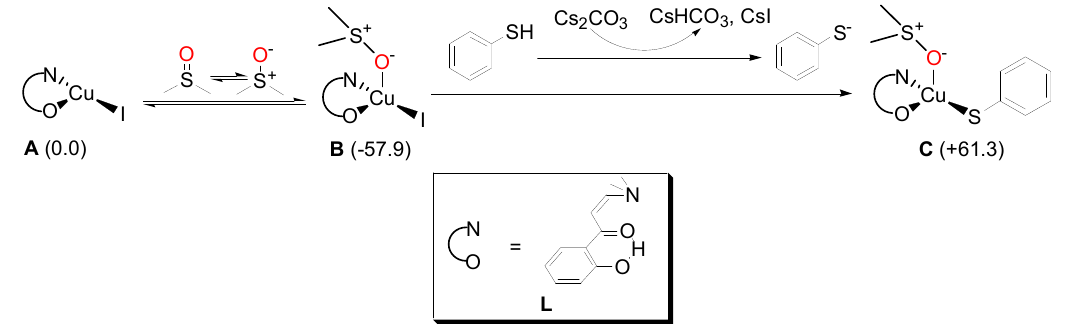
Scheme 5. Nucleophile coordination and ligand exchange.